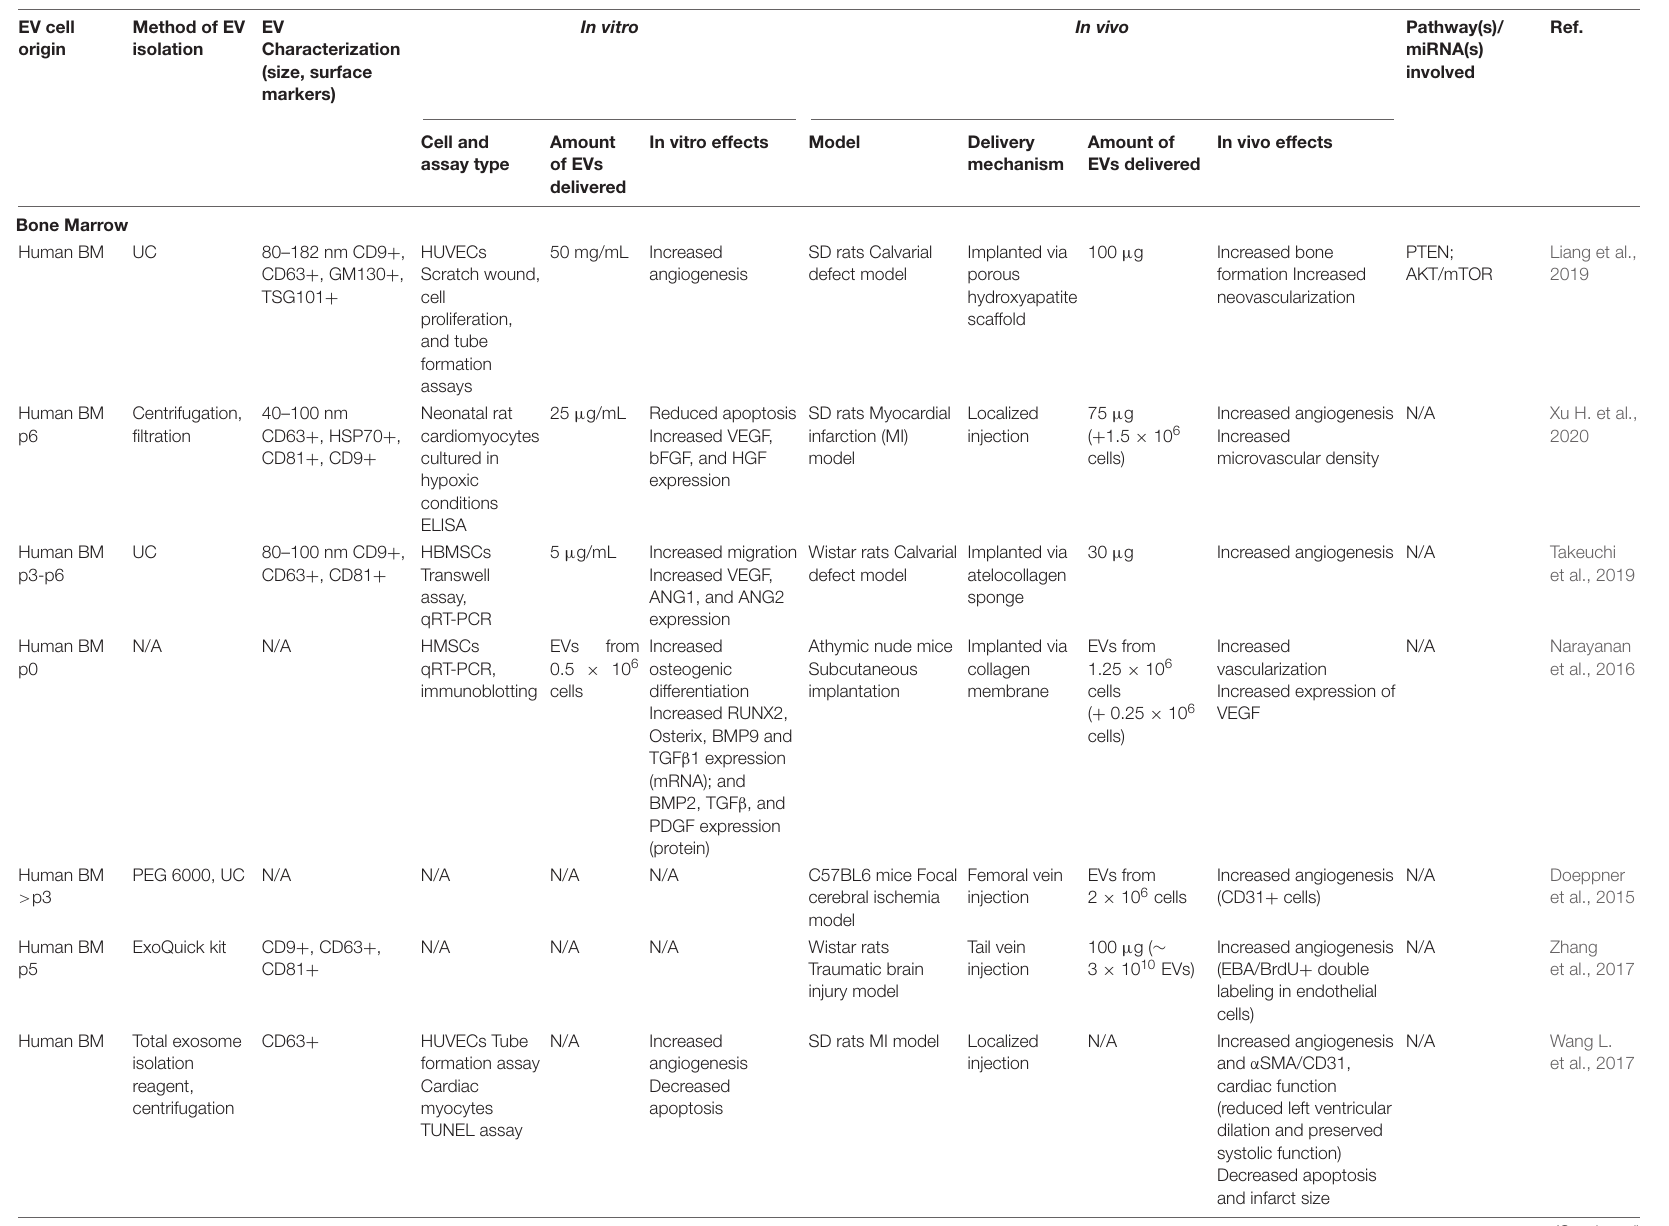
TABLE 1 | Preclinical studies employing BMMSC- and ADMSC-derived EVs to induce